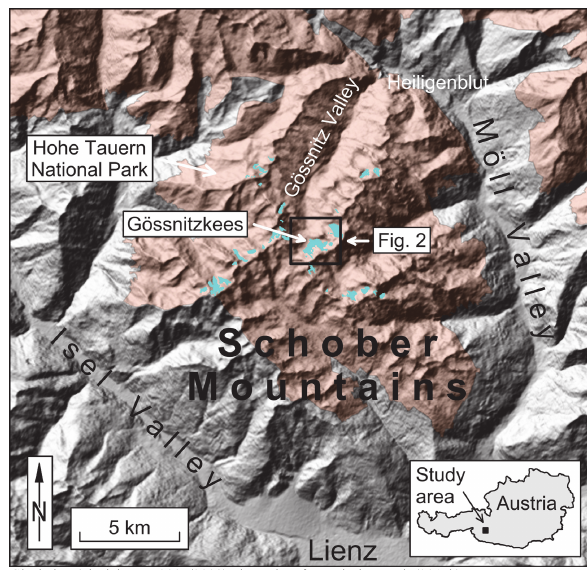
Figure 1. Location map